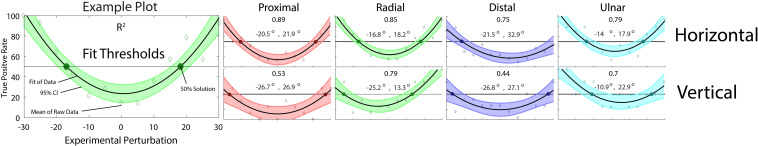
Polynomial regression fits of response sensitivity. For each primary stimulus in each grip condition, detection rate (DR) is calculated as a secondary stimuli’s True Positives over the sum of respective True Positives (TP) and False Negatives (FN). The PSD mark represents where TP ≥ FN. Subjects who showed a DR ≤ 50% for ±30° or 0° secondary stimuli were excluded due to lack of attention or focus during the experiment. For all subjects, the mean DR is overlaid with a second order polynomial regression fit and respective 95% confidence intervals. Solutions for 50%, and R2 are given for each plot.